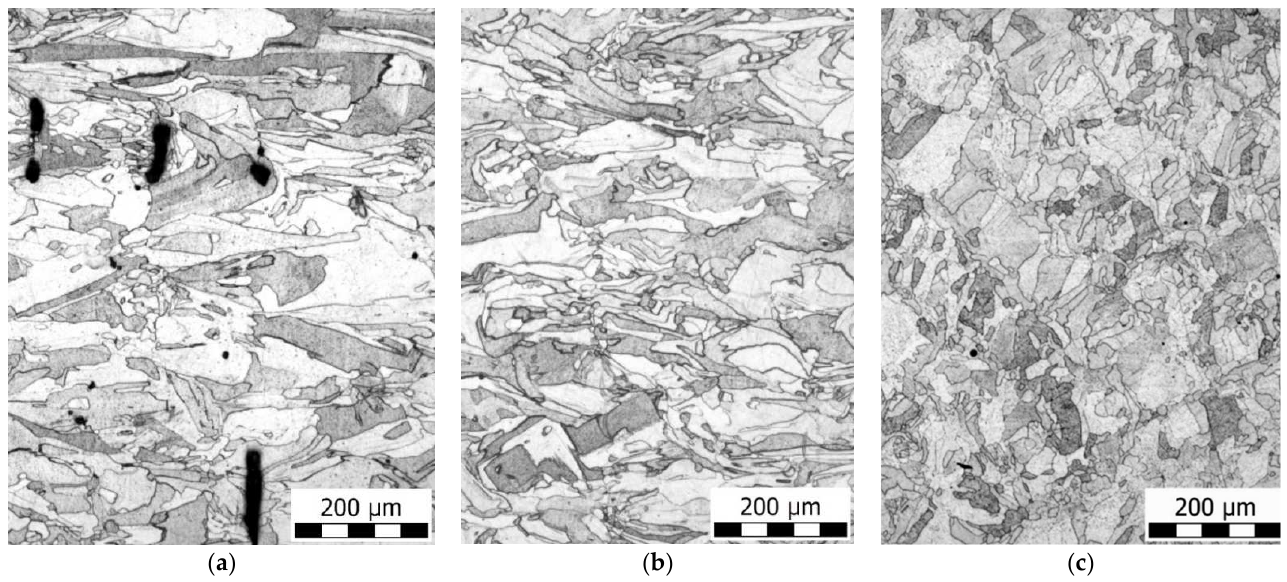
Figure 9. Dendritic arrangement of microstructure and precipitates along grain boundaries (sample 3D).